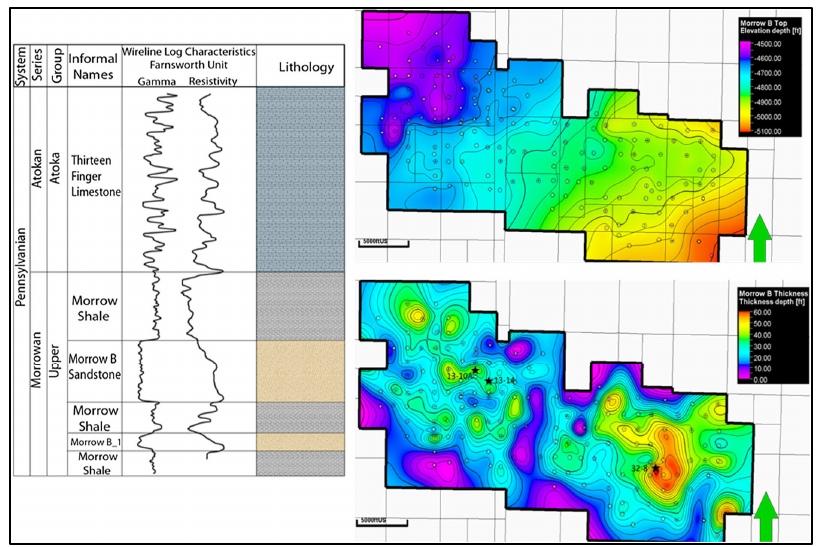
Figure 2. ( Left ) type log of FWU caprock and reservoir. ( Upper right ) surface contour of Morrow B top with 200 ft depth contour intervals. ( Lower right ) thickness map of Morrow B sands and location of characterization wells with 2 ft thickness contour intervals.